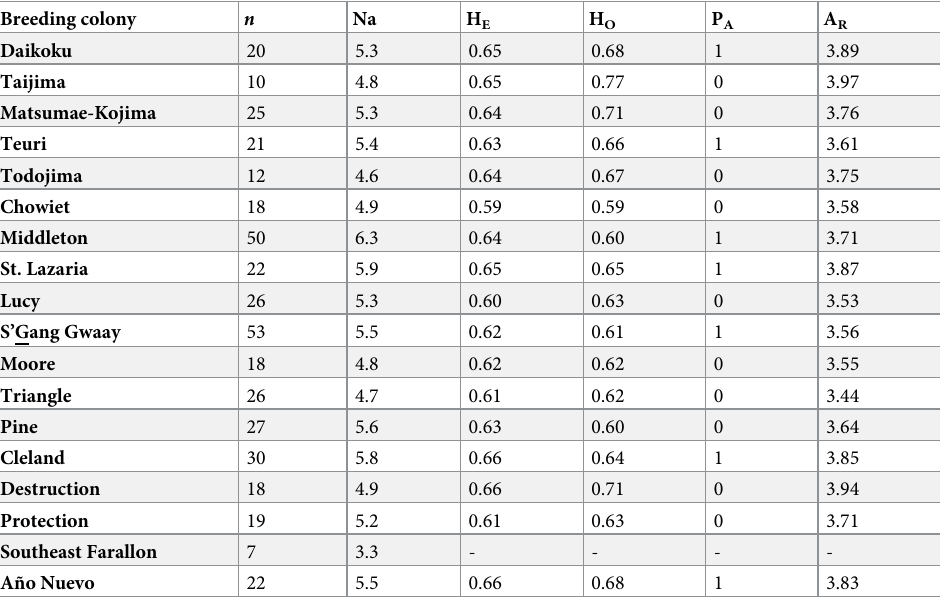
For some measures, values are excluded for Southeast Farallon Island because of small sample size and data missing from locus